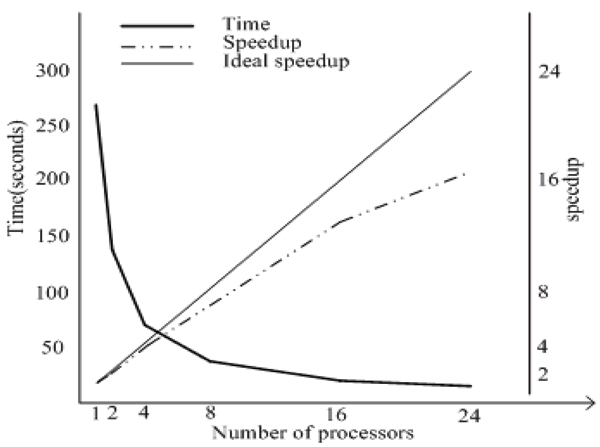
The execution time and speedup of PMC-SVM on mimosa with Dataset 2 (Mnist1_scale).